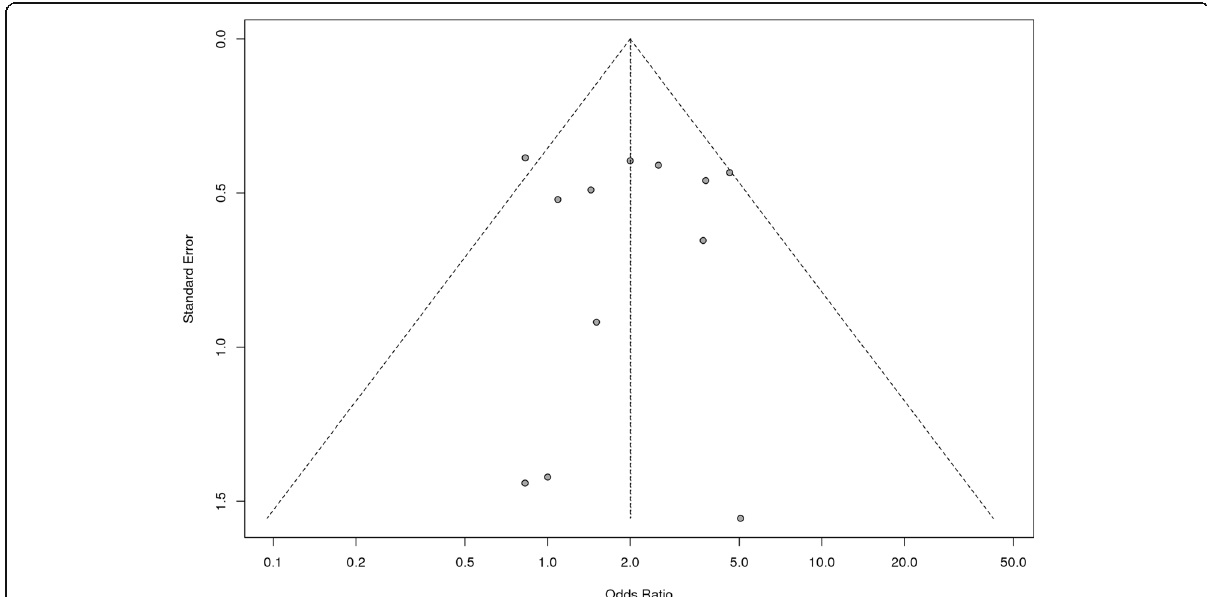
Fig. 5 Funnel plot for APOE gene polymorphism and CAD risk for ε 4